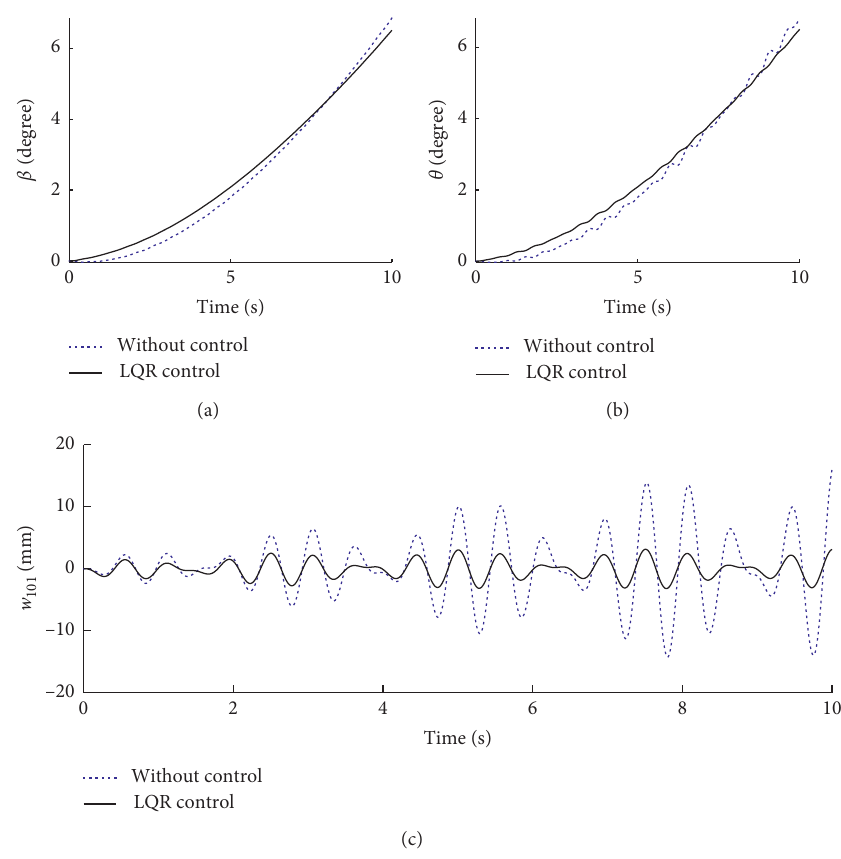
Figure 11: Response of the controlled system with hybrid